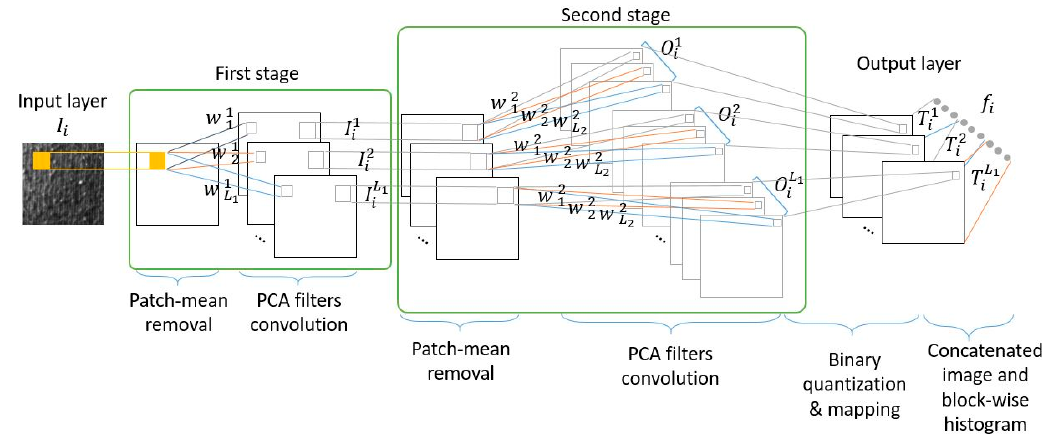
Figure 2. Diagram of deep principal components analysis (DPCA).